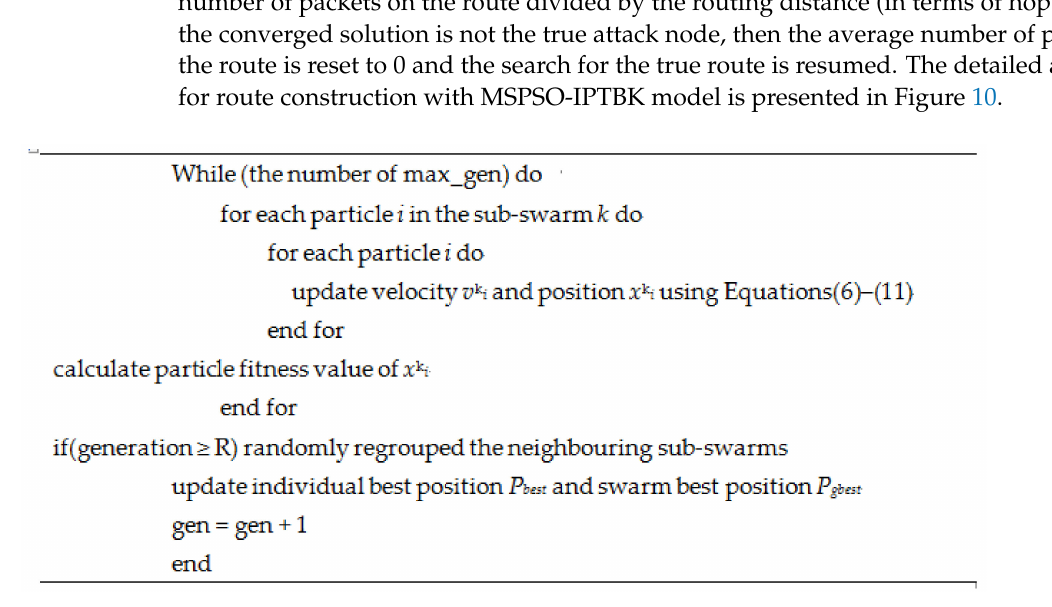
Figure 10. MSPSO-IPTBK